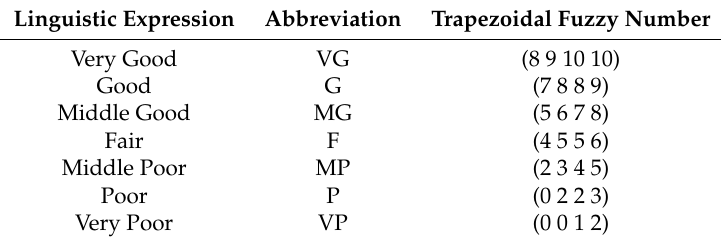
Table 3. Linguistic variables for